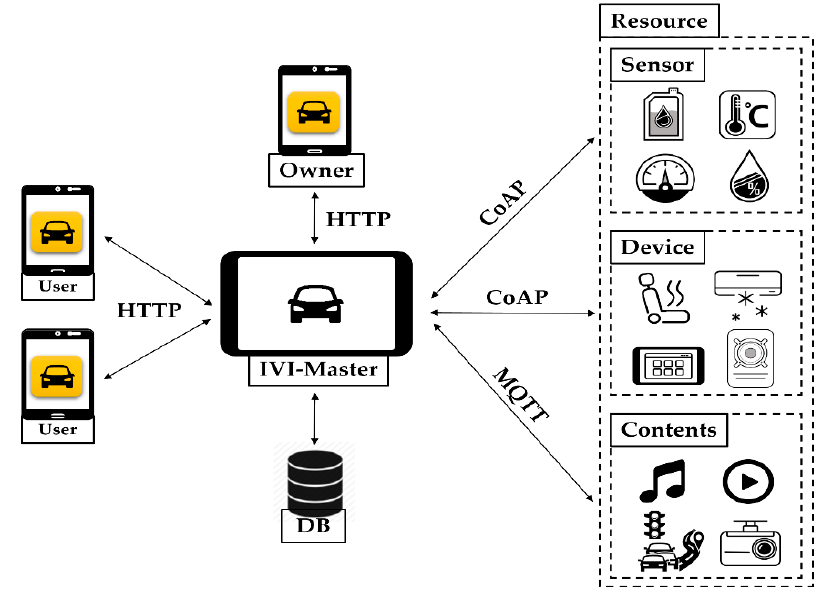
Figure 2. Architecture of proposed IVI system.